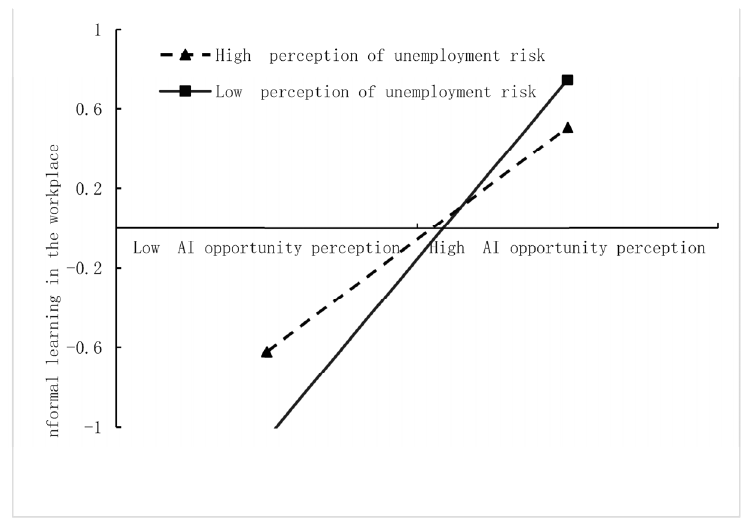
Figure 6. Interaction effect of URP on the relationship between AI opportunity perception and